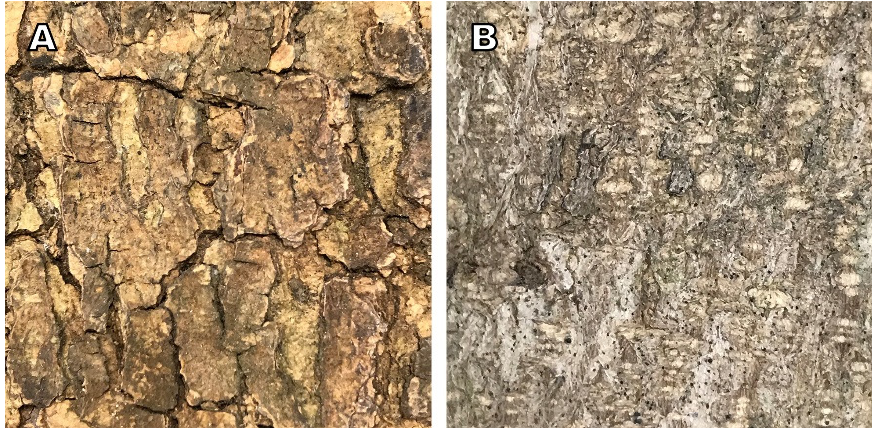
Figure 1. Bark surface of Acacia mangium ( A ) and A cacia hybrid ( B ). Several researchers have reported the bark morphology of Acacia wood species, which are consistent with the results of our study. Specifically, Krisnawati et al. [12] reported results similar to those obtained from our study; A mangium from Indonesia exhibiting hard, rough, and fissured bark with brown to dark-brown color. Furthermore, Sein and Mitlöhner [13] reported that A. mangium from Vietnam had fissured bark with a greyish- to dark-brown color. Hedge et al. [18] also explained that A. mangium had a rough bark with a greyish brown to brown color. Additionally, Sein and Mitlöhner [14] reported that the morphological trait of A. hybrid bark was a mixture of A. mangium and A. auriculiformis, and differed from that of a typical A. mangium , however, it was similar to that of A. auriculiformis as it had a smooth and scaly bark with greenish-brown to brown color. Lastly, Sunarti et al. [31] reported that A. hybrid from Indonesia had a smooth bark with a greenish-brown color. The wood discs of A. mangium and A. hybrid are shown in Figure 2. A. mangium had distinctly different colors for heartwood and sapwood. Heartwood was greyish- to olive- brown, while sapwood was creamy- to yellowish-white (Figure 2A). In A. hybrid , there was a slight difference in color between the heartwood and sapwood (Figure 2B). The color of heartwood and sapwood in A. mangium was darker than that in the A. hybrid (Figure 2). In this study, the color of the heartwood and sapwood of A. mangium and A. hybrid was similar to that reported in previous studies. Specifically, Abdul-Kader and Sahri [19] reported that the heartwood color of A. mangium from Malaysia was dark-brown, whereas the sapwood was light-cream. Moreover, Ogata et al. [21] reported that the heartwood color of A. mangium was pale-brown, yellowish-brown, and brown, whereas the sapwood was pale- yellow. Sein and Mitlöhner [13] also reported that the heartwood color of A. mangium from Vietnam was pale olive-brown and greyish-brown to brown, and the sapwood color was yellowish-white to cream. Further, Andianto et al. [22] reported that the heartwood color of Indonesian A. mangium was pale- to dark-brown and the sapwood color was pale-yellow to yellow. Lastly, Praptoyo [23] reported that the Indonesian A. hybrid was pale-brown and yellowish- to dark-brown, and the sapwood color was pale yellowish-white to